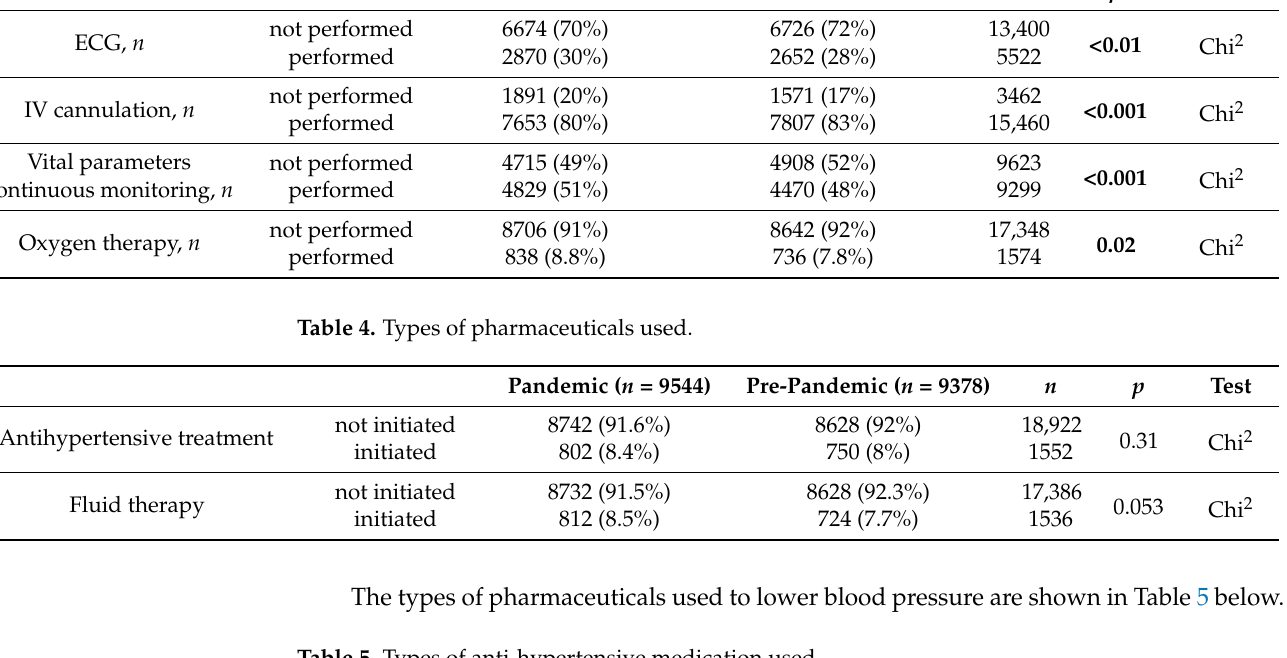
Table 5. Types of anti-hypertensive medication used.